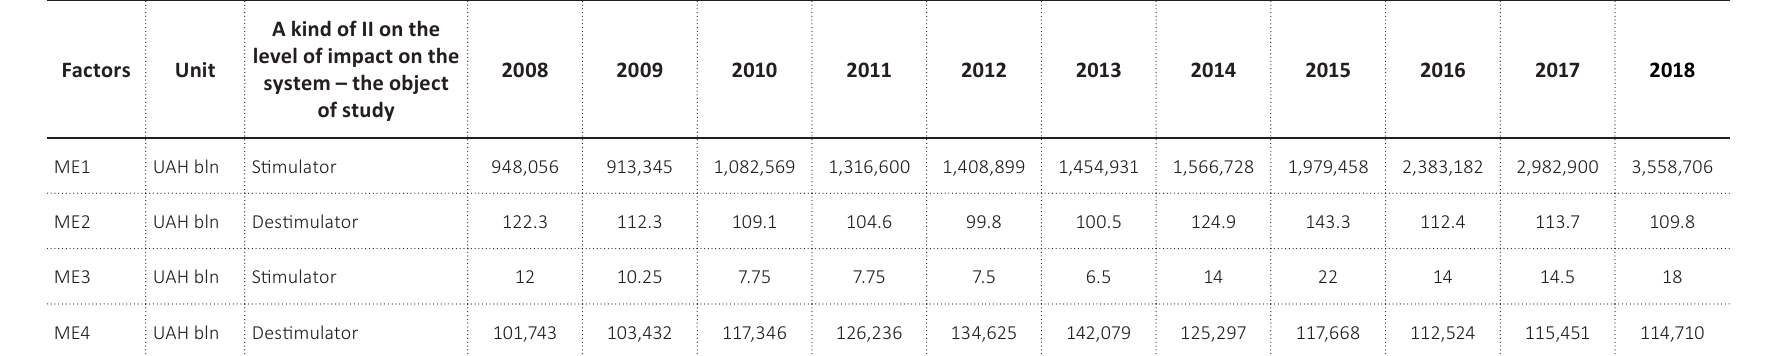
Table B3. System of indicators of the “Macroeconomic stability”